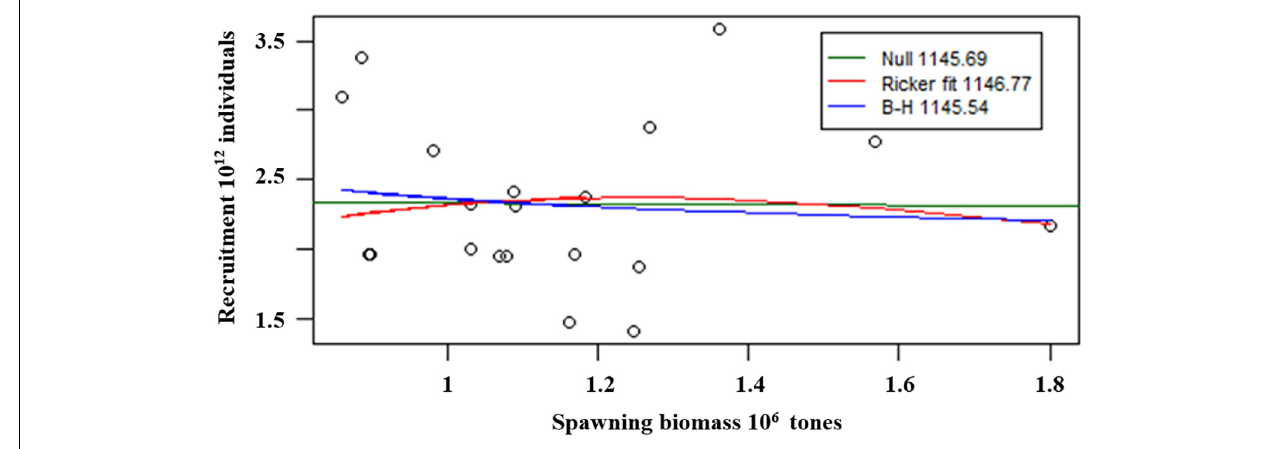
FIGURE 10 | Fits of spawning biomass-recruitment relationship.